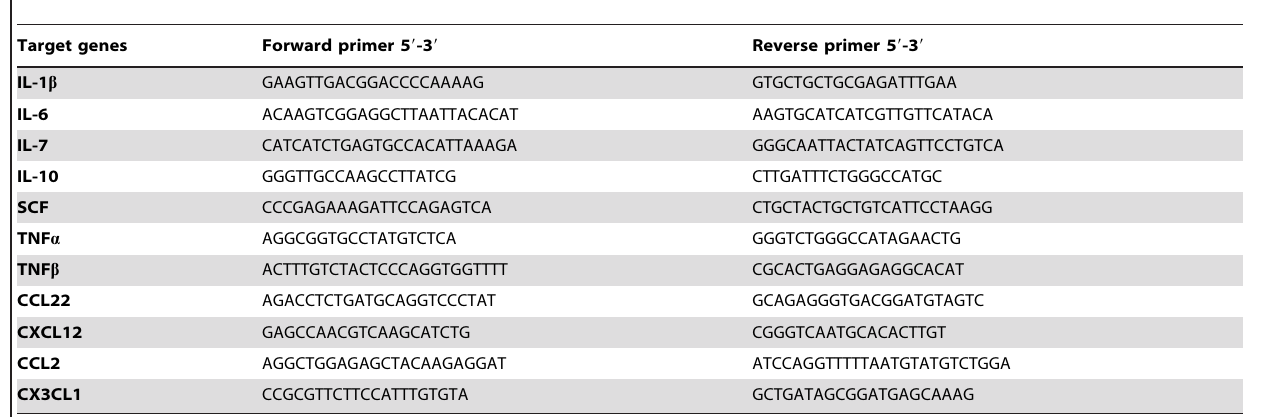
Table 1. Primer sequences used for quantitative real-time polymerase chain reaction.